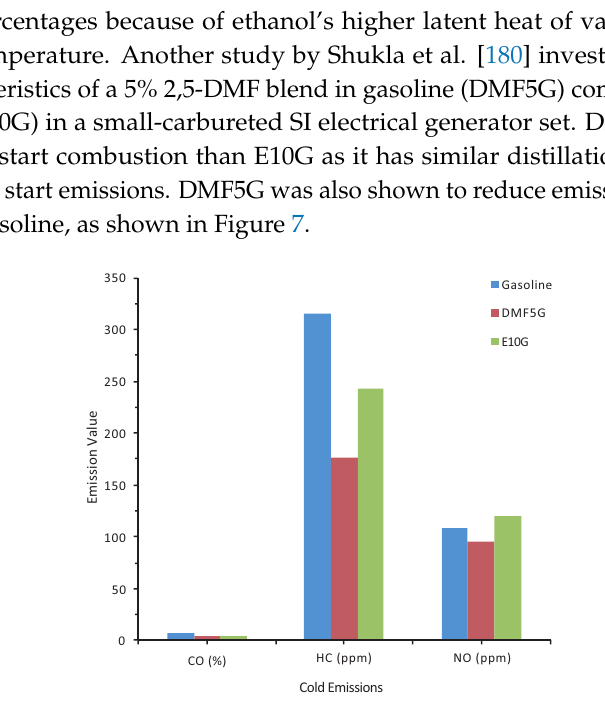
Figure 7. Comparative cold emission of pure gasoline compared to a 5% 2,5-DMF blend in gasoline (DMF5G) and a 10% ethanol blend in gasoline (E10G) (Adapted from Shukla et al.